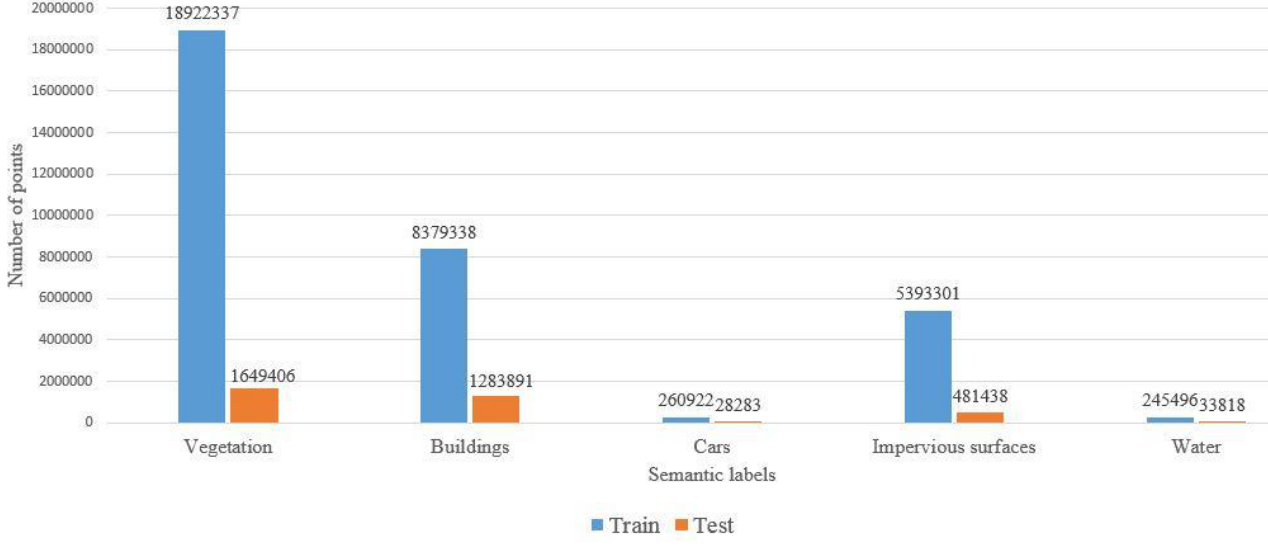
Figure 3. The distribution of different semantic classes in the created dataset.